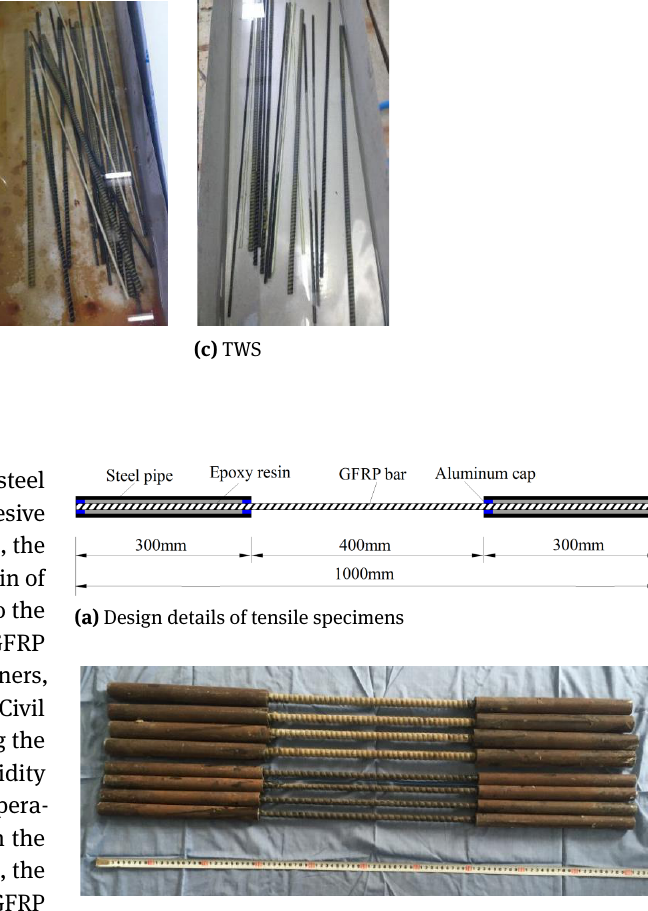
1000 mm long and the length of the test part between two anchored ends was 400mm. The prepared tensile speci- mens of GFRP bars were shown in Figure